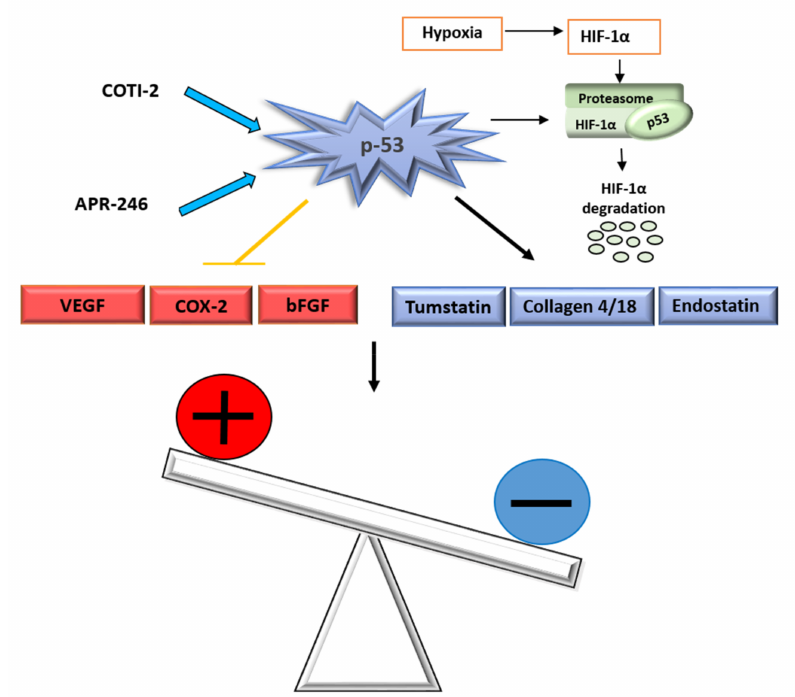
Figure 3. p53 negatively regulates angiogenesis. It inhibits proangiogenic proteins VEGF, COX-2 and bFGF and stimulates angiogenesis inhibitors tumstatin, endostatin and type 4 and type 8 collagen, thus tilting the scale in favor of anti-angiogenesis. HIF-1 α , hypoxia inducible factor-1 α VEGF, vascular endothelial growth factor; COX-2, cyclooxygenase; bFGF, basic fibroblast growth factor, − , anti-angiogenesis; +, proangiogenesis; , drug inhibition; , suppress; → ,